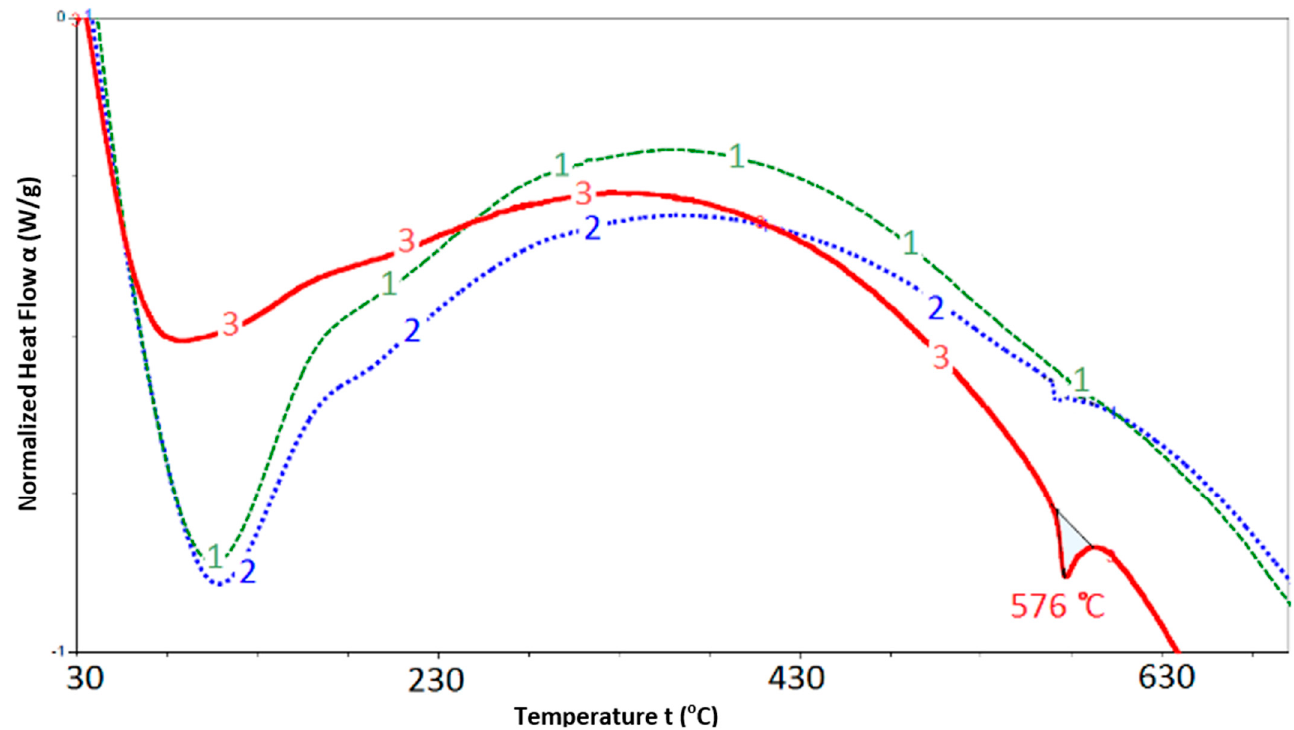
Figure 2. Thermal analysis of samples: 1—SCM; 2—mechanically activated SCM; 3—quartz sand (98% SiO 2 ).